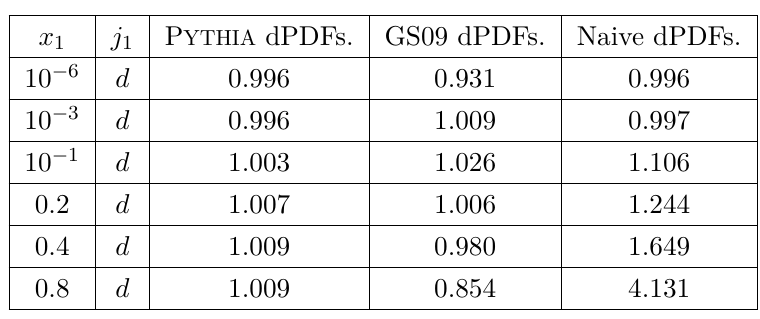
Table 3 . Check of the momentum sum rule for the P YTHIA , GS09 and naive models of dPDFs. In the ideal situation when the momentum sum rule is perfectly satisfied the number in each cell should be equal to